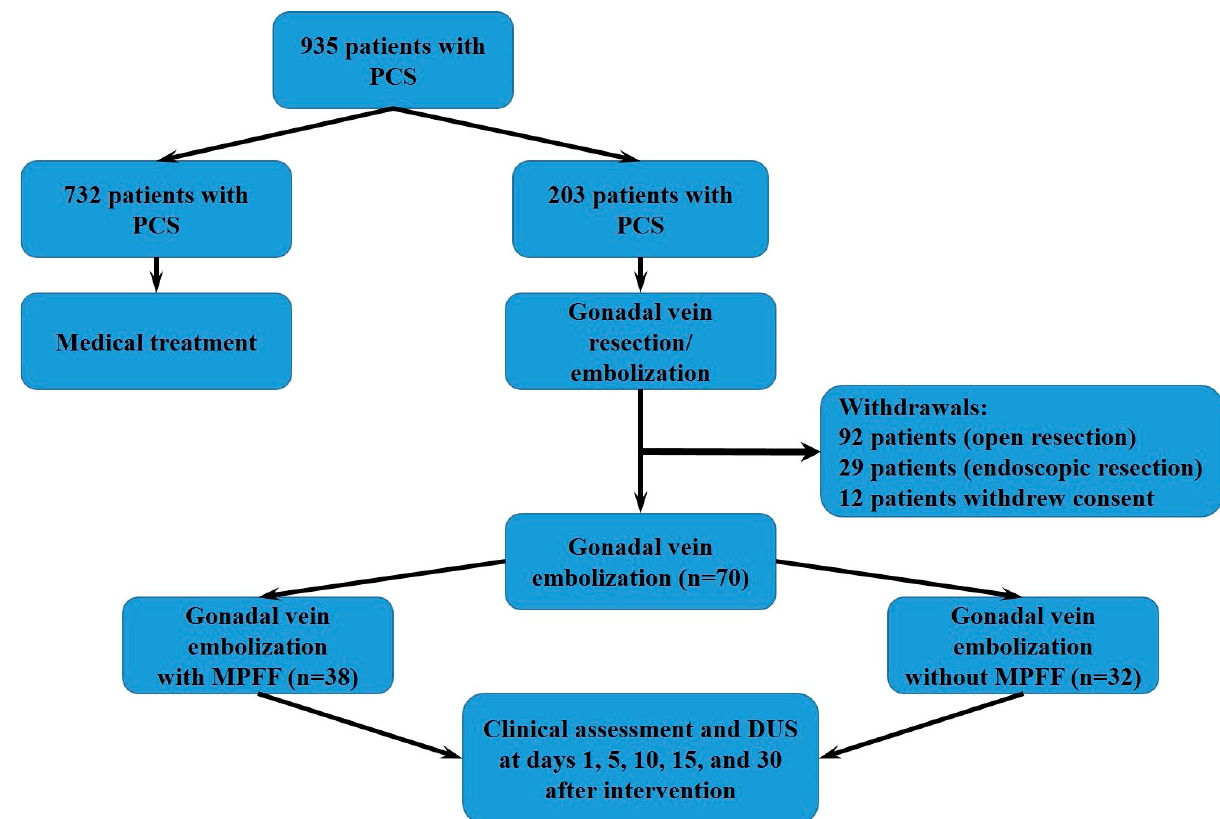
Figure 1. The study flowchart.